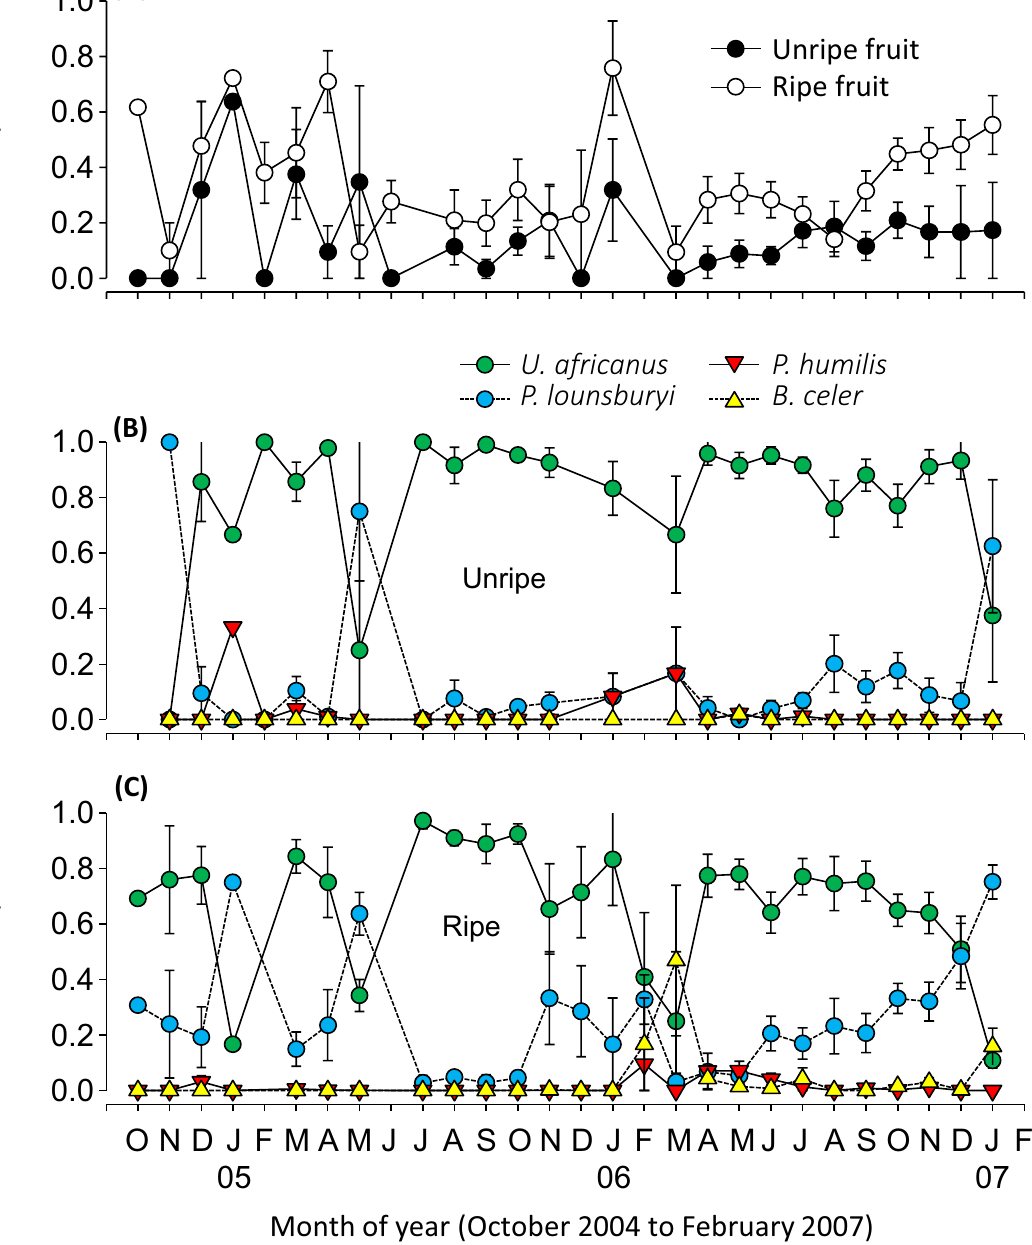
Figure 6. For both unripe and ripe fruit, the seasonal dynamics of ( A ) parasitoid species diversity (Shannon index) of the braconid parasitoid species reared from the collected flies, and relative abundance of braconid parasitoid species reared from B. oleae and B. biguttula on ( B ) unripe fruit and ( C ) ripe fruit in the Western Cape, South Africa. Values are mean and SE and data were pooled from different collection sites. The figure was created using JMP Pro ver13 (SAS, Cary,